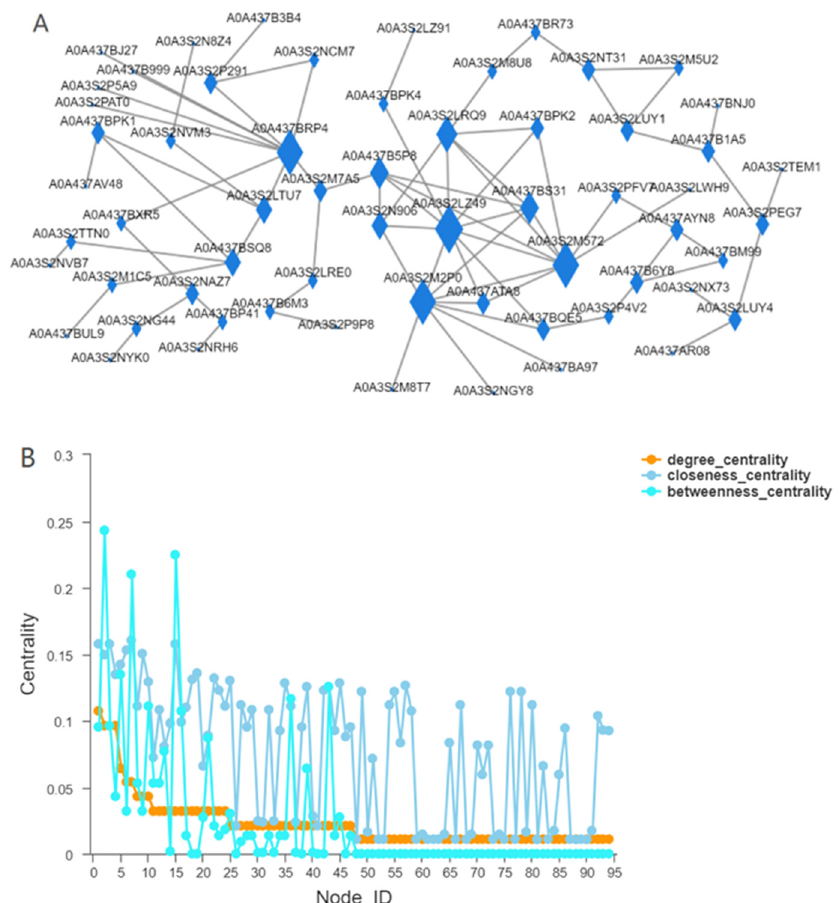
Figure 9. Protein interaction network. ( A ): Nodes represent genes, and edges represent interactions between two genes. The size of a node is directly proportional to the connectivity (degree) of the node; that is, the more edges connected to the node, the larger the degree of the node will be, indicating the stronger the importance of genes in the network. ( B ): The horizontal coordinate is the ID of the node, and the vertical coordinate is Centrality. The larger the value is, the more important the node is in the network. In the figure, the blue color represents betweenness centrality, which reflects the role of a node in connection with other nodes. It means that the node plays a more important role in maintaining the tight connectivity of the whole network); Orange represents degree centrality (degree centrality is the most direct metric to describe node centrality in network analysis. The greater the degree of a node is, the higher the degree centrality of the node is, and the more important the node is in the network). Light blue represents the closeness coefficient (which is the distance between a node and other nodes in the network, if all are very short, the point is the center of the whole, and the larger the value is, the closer the node is to the center of the network).